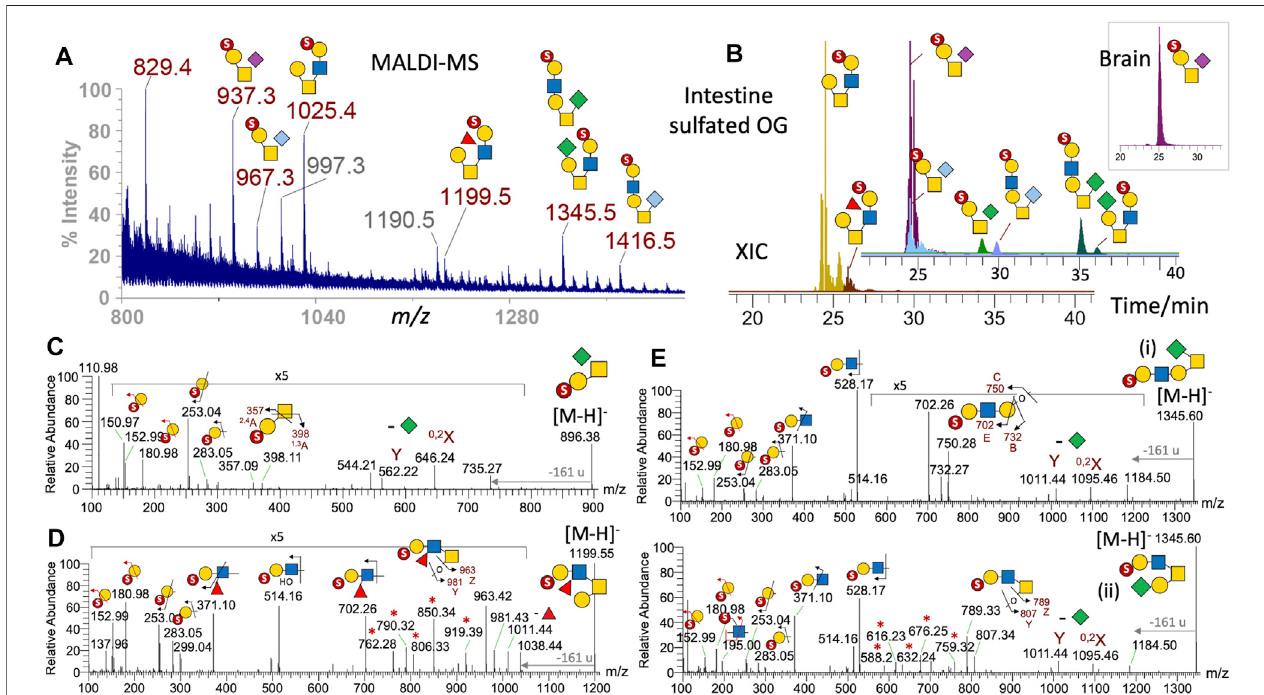
FIGURE 4 | Sulfated O-glycans of adult zebra fi sh. The sample fractions containing permethylated mono- and multiply sulfated O-glycans derived from the brain, intestine, and ovary were fi rst screened by MALDI-MS, which detected assignable signals only in the brain and intestine monosulfated fractions. The former contained a single [M-H] - signal at m/z 937, which was also found among a range of other signals in the intestine sample (A) . Full structural assignment was based on further nano- LC-MS/MSanalysis,andtheXICsofeachidenti fi edintestinemono-sulfatedO-glycanswereoverlaidtoreconstructa fi lteredLC-MSpro fi le (B) .Twonon-sialylated core 2 structures were eluted around the same time as the NeuAc/NeuGc-sialylated core 1 structures, and their overlaid XICs were separately plotted using the same intensity scale and time axis in (B) for better visualization. Similar ion extraction revealed only a sulfated NeuAc-sialylated core 1 structure in the brain (inset at top right). Representative negative mode MS/MS establishing the sialylated core 1 and non-sialylated core 2 structures is shown in (C) and (D) , respectively. The diagnostic low- mass ions at m/z 153 and 181 together with the E 1 and B 1 ions at m/z 253 and 283 collectively identify a terminal 3-O-sulfated Hex commonly found in all sulfated O-glycans identi fi ed here, and the sulfated N-glycans ( Figure 3F ). The additional 2,4 A 2 and 1,3 A 2 ions at m/z 357 and 398 in (C) indicate that the 3-O-sulfated Hex is 3- linked to an HexNAc, as would be expected for the core 1 structure, whereas the 3,5 A 2 ion at m/z 371 in (D) implies that it is 4-linked to the HexNAc, as found also in all core 2 structures. The MS 2 spectra of the sulfated NeuAc/NeuGc-sialylated core 1 structures (not shown) are similar to that sialylated by KDN (C) with the loss of the different sialic acids producing the same Y and 0,2 X ions at m/z 562 and 646. The KDN-sialylated O-glycans at m/z 1,345 were clearly resolved into 2 distinct isomeric peaks by LC (B) and their respective core 1 and 2 structures unambiguously established by MS/MS (E) . Ion series marked with asterisks are characteristic satellite ions associated with the sulfated fucosylated LacNAc (D) and LacNAc (E) located on the 6-arm of core 2 structures. All diagnostic ions including the loss of 161 u from the GalNAcitol have been described previously (Cheng et al.,